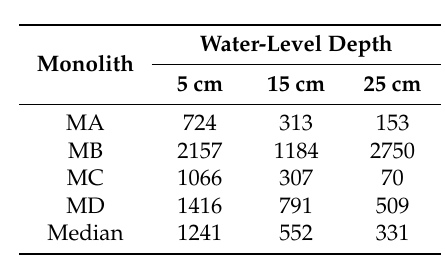
Table 3. Lateral saturated soil hydraulic conductivities, K s,l (mm · h − 1 ), estimated from the drainage experiments in the five soil monoliths for the water-level depths (WLD) of 5 cm, 15 cm and 25 cm from the soil surface.